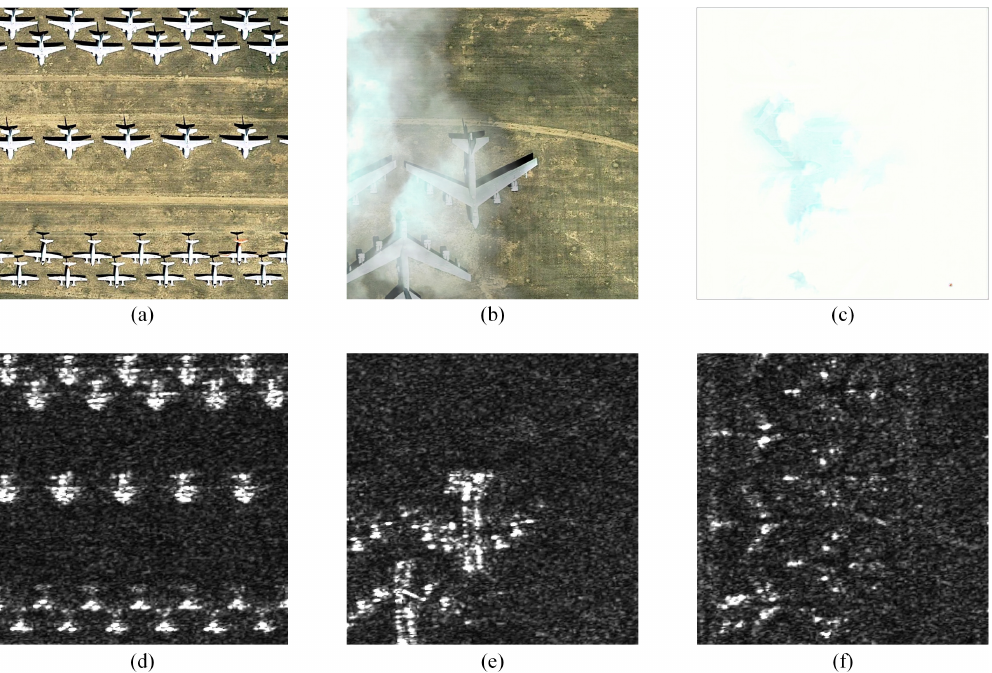
Figure 7. Typical images in the FCAD dataset. ( a ) The optical image and ( d ) the SAR image in the cloudless scenes; ( b ) the optical image and ( e ) the SAR image in the thin-cloud scenes; ( c ) the optical image and ( f ) the SAR image in the thick-cloud